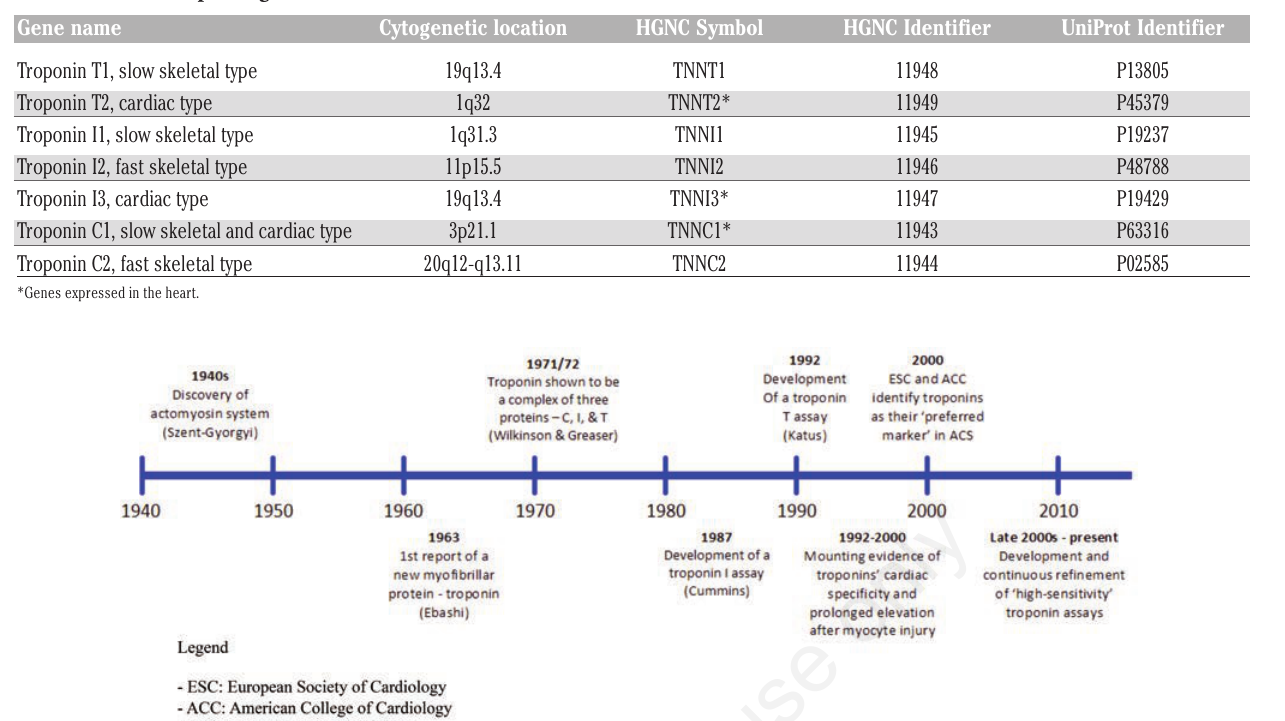
Table 1. Human troponin genes.